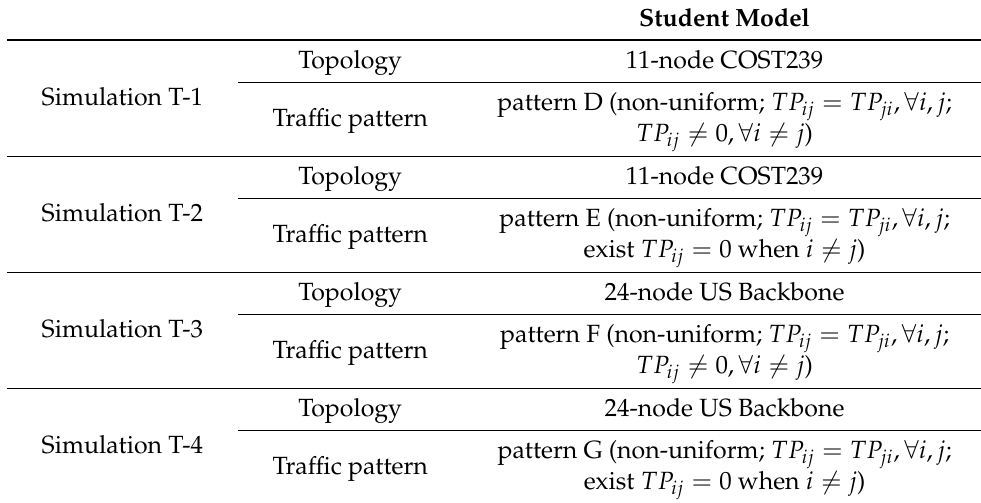
Table 5. Simulation settings for the student models in Section 4.4.